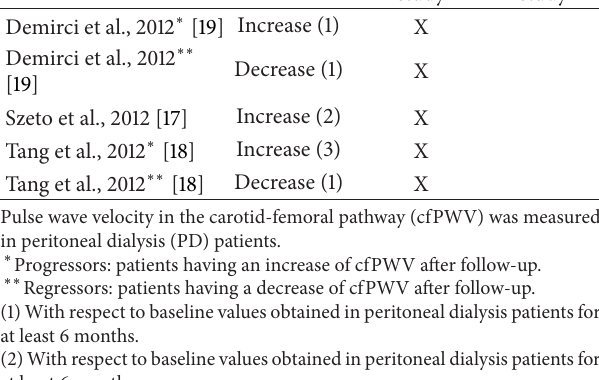
Table 2: Arterial (aortic) stiffness in peritoneal dialysis patients. Longitudinal cfPWV in PD study